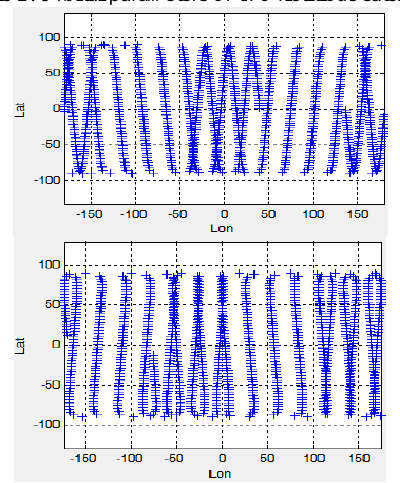
Table 2. Orbital parameters of two fictitious satellites